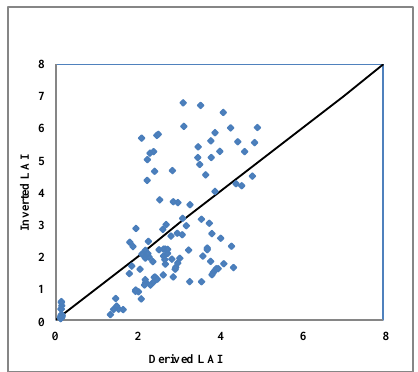
Figure 3. Comparison of LAI inverted from RADARSAT-2 entropy and LAI derived from optical imagery